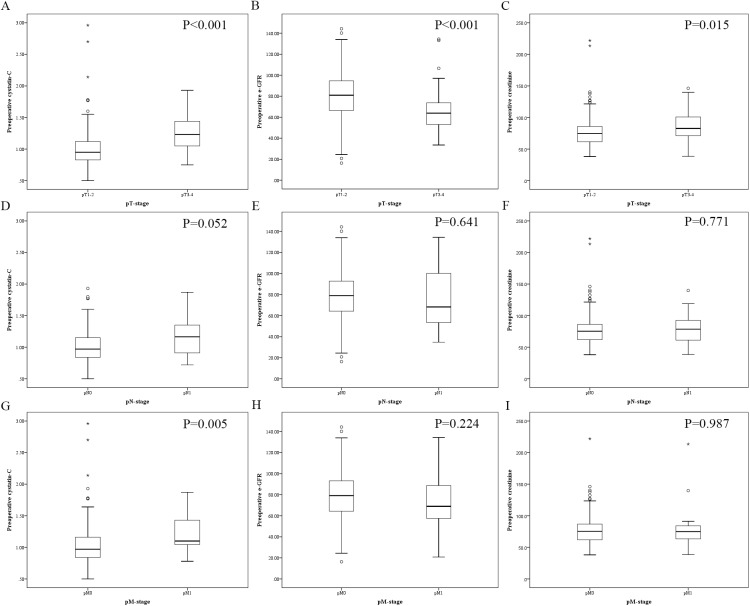
Box plot diagrams showing the level of preoperative cystatin C, estimated glomerular filtration rate (e-GFR) and creatinine (CRE) in different pT-status, pN-status, and pM-status.(A) Cystatin C in pT1-2 and pT3-4 RCC patients, (B) e-GFR in pT1-2 and pT3-4 RCC patients, (C) CRE in pT1-2 and pT3-4 RCC patients, (D) Cystatin C in pN0 and pN1 RCC patients, (E) e-GFR in in pN0 and pN1 RCC patients, (F) CRE in pN0 and pN1 RCC patients, (G) Cystatin C in pM0 and pM1 RCC patients, (H) e-GFR in pM0 and pM1 RCC patients, (I) CRE in pM0 and pM1 RCC patients.